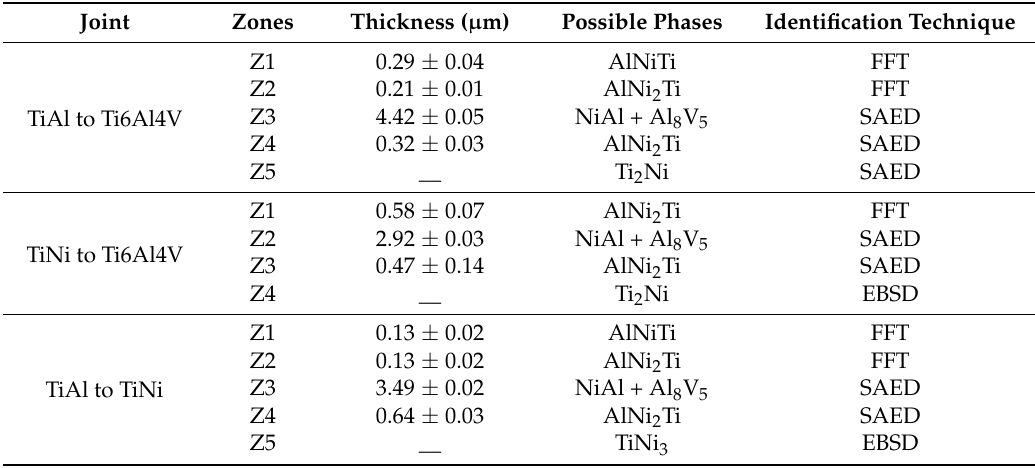
Table 1. Phase identification of the zones indicated in Figure 3 that comprised the interfaces of the titanium alloys dissimilar joints produced at 800 ◦ C under a pressure of 20